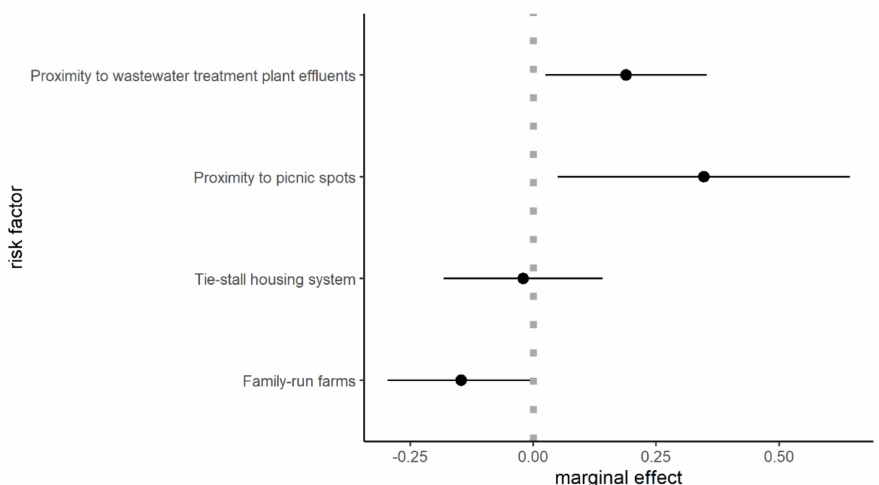
Figure 2. Estimated marginal effects for significant variables ( p < 0.05). Dots indicate the average marginal effect while bars indicate standard error. Dotted lines indicate the threshold between negative/positive effect on the probability of BC